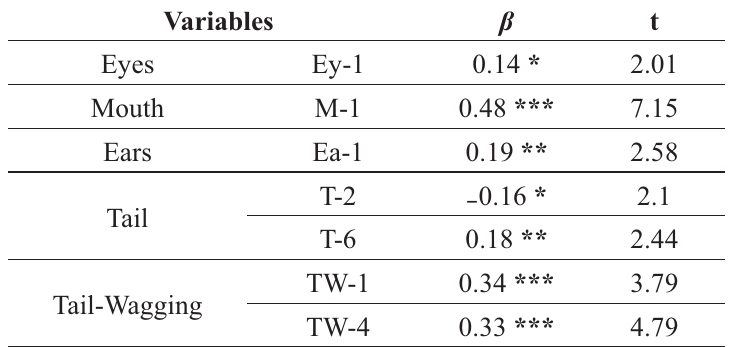
Table 4. Statistical results on the duration of each behavioral category as good predictors of the achievement rate in the operant conditioning tests (Stepwise multiple regression